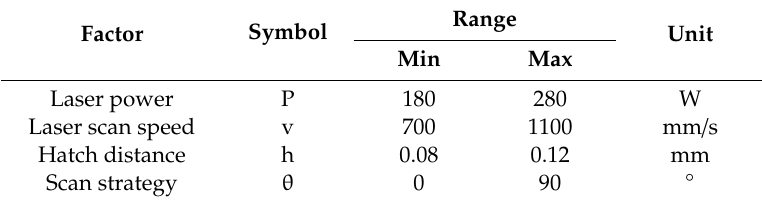
Table 2. Factors, ranges and units of the design of experiments.